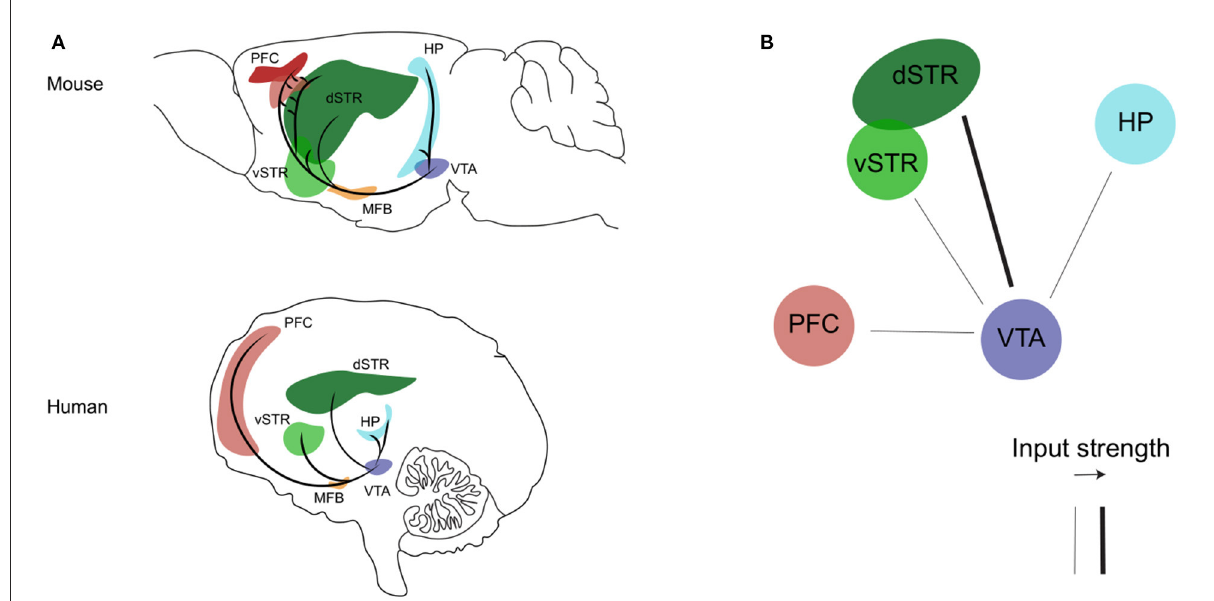
FIGURE1 The mesocorticolimbic dopaminergic system. (A) Sagittal view of the mesocorticolimbic dopamine pathway and its principal target nuclei in the mouse (upper) and human (bottom) brain. (B) Representation of the impaired (thin line) dopaminergic inputs from the VTA described so far during the progression of AD (see text for details). Representations are adapted from the mouse and human brain atlas (Allen Institute). PFC, prefrontal cortex; HP, hippocampus; dSTR, dorsal striatum; vSTR, ventral striatum; MFB, medial forebrain bundle; VTA, ventral tegmental